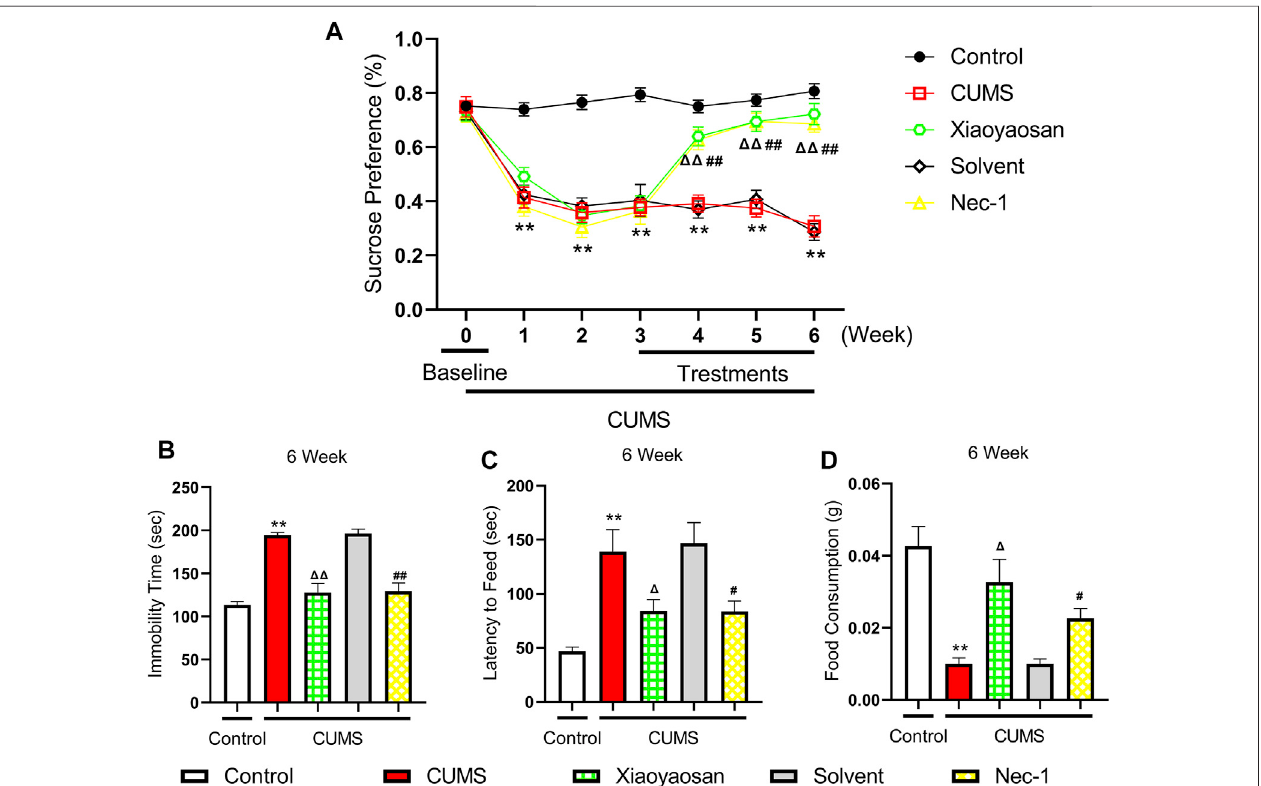
FIGURE5| ChangesintheDepressive-likebehaviorsofCUMSmice (A) ChangesofsucrosepreferencerateduringtheCUMSmodelingperiod(n (cid:1) 15) (B) FStest results after the 6-weeks modeling (n (cid:1) 15) (C) The results of latency to feed in NSF test after the 6-weeks modeling (n (cid:1) 15) (D) The results of food consumption in NSF testafterthe6-weeksmodeling(n (cid:1) 15).Datawereexpressedasmeans ± SEM,** p < 0.01versuscontrolgroup; Δ p < 0.05, ΔΔ p < 0.01versusCUMSgroup;# p < 0.05, ## p < 0.01 versus solvent